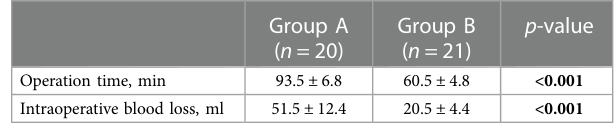
TABLE 2 Operation time and intraoperative blood loss.